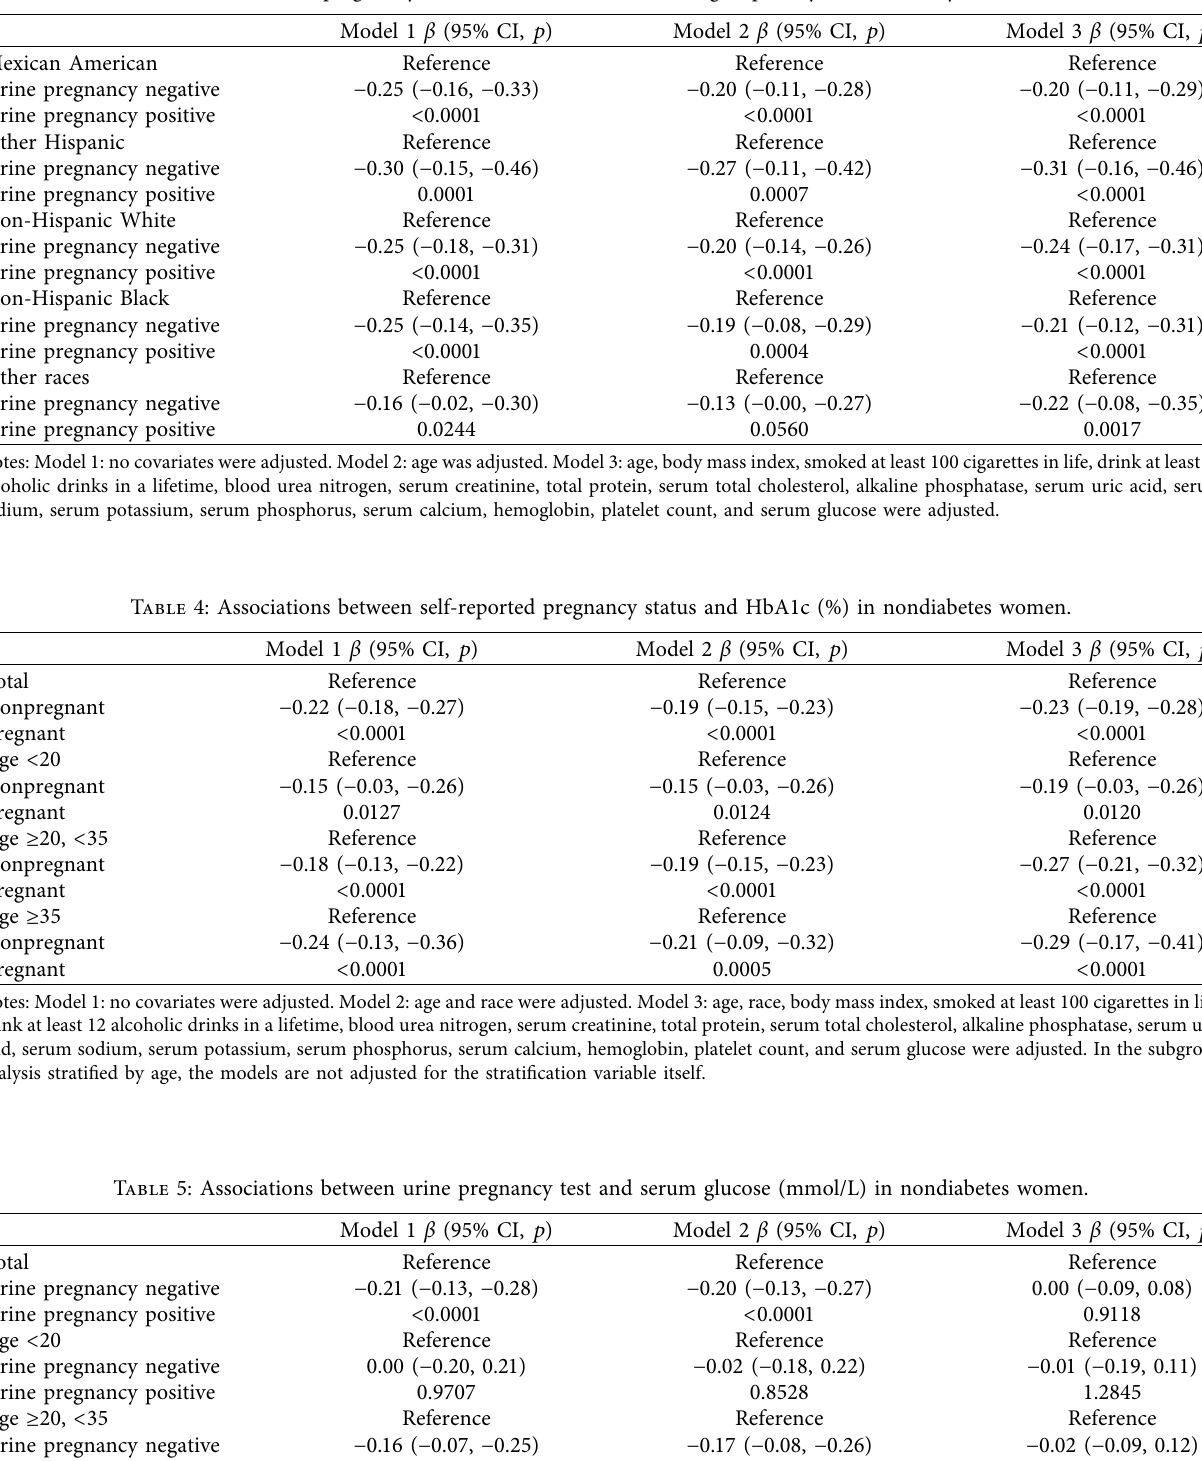
Table 3: Associations between urine pregnancy test and HbA1c (%) in the subgroup analysis stratified by race in nondiabetes women.